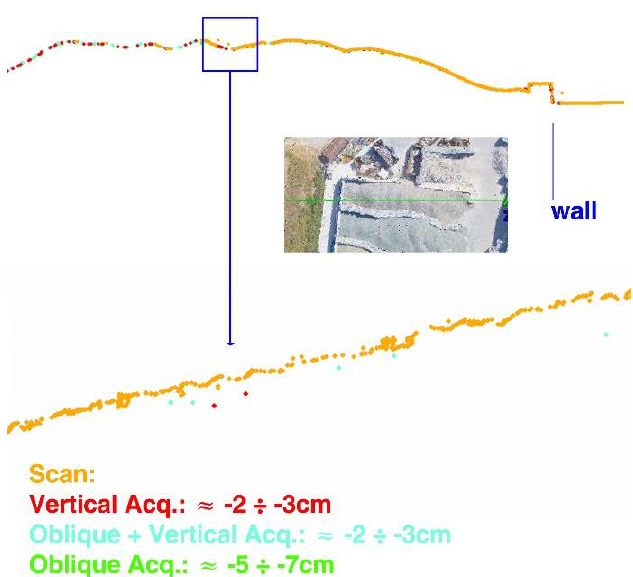
Figure 22. Comparison between point cloud profiles.